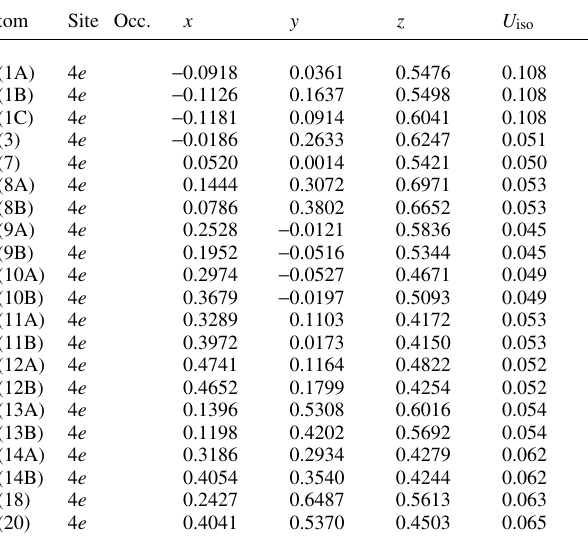
Table 2. Atomic coordinates and displacement parameters (in Å 2 ) .